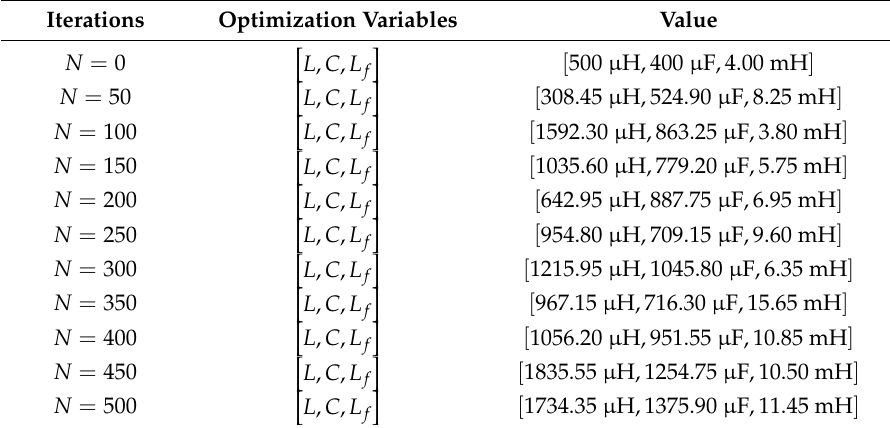
Table 7. Multi-objective optimization results.